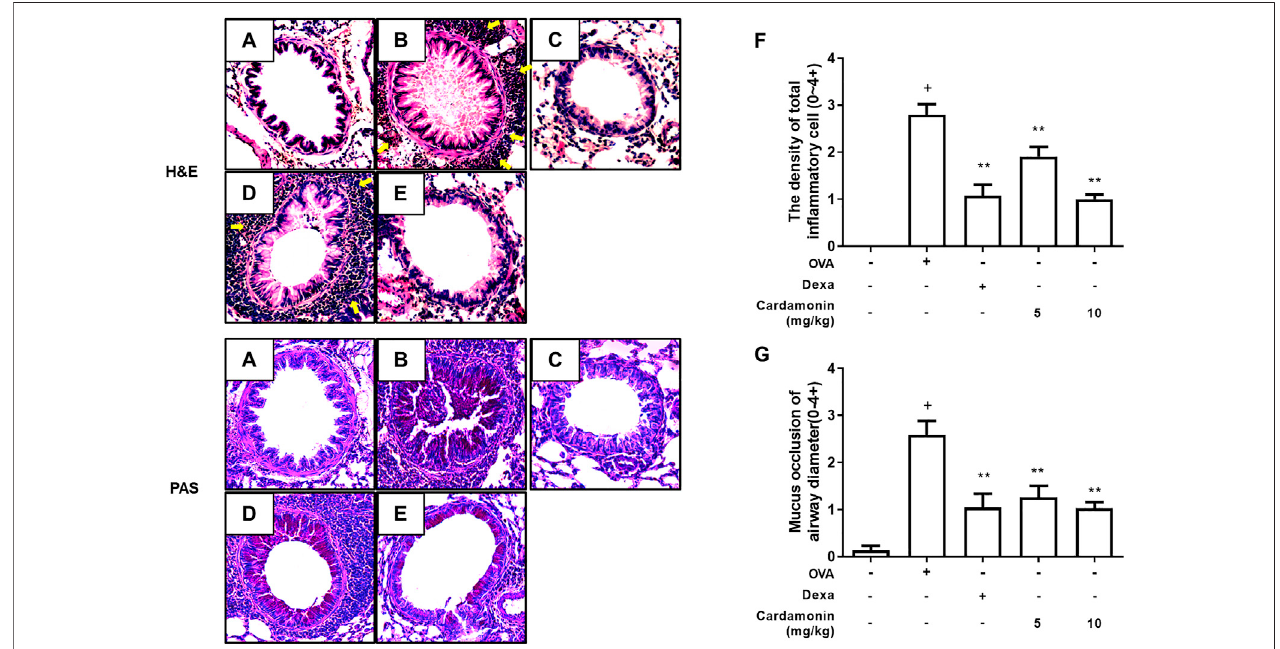
FIGURE 5 | The effect of cardamonin on histopathological changes in the lung tissues of OVA-induced allergic airway in fl ammation model. In fl ammation was evaluated in the lung tissues by analyzing in fl ammatory cell in fi ltration (H&E staining) and goblet cell hyperplasia (PAS staining). Representative lung tissue sections from the sham group (A) , the OVA sensitized and challenged mice treated with vehicle (B) , dexamethasone (1 mg/kg) (C) , or with cardamonin (5 and 10 mg/kg) (D and E) . The number of peri-bronchial in fl ammatory cell was upregulated in mice receiving the vehicle compared with mice receiving sham treatment (F) . Mucus occlusion was signi fi cantly attenuated in mice of allergic airway in fl ammation treated with cardamonin (G) . The H&E and PAS stained sections are magni fi ed × 200. The values presented are means ± SEM. n (cid:1) 3 – 6, + p < 0.05 compared with the sham group; * p < 0.05, ** p < 0.01 compared with the vehicle group treated with